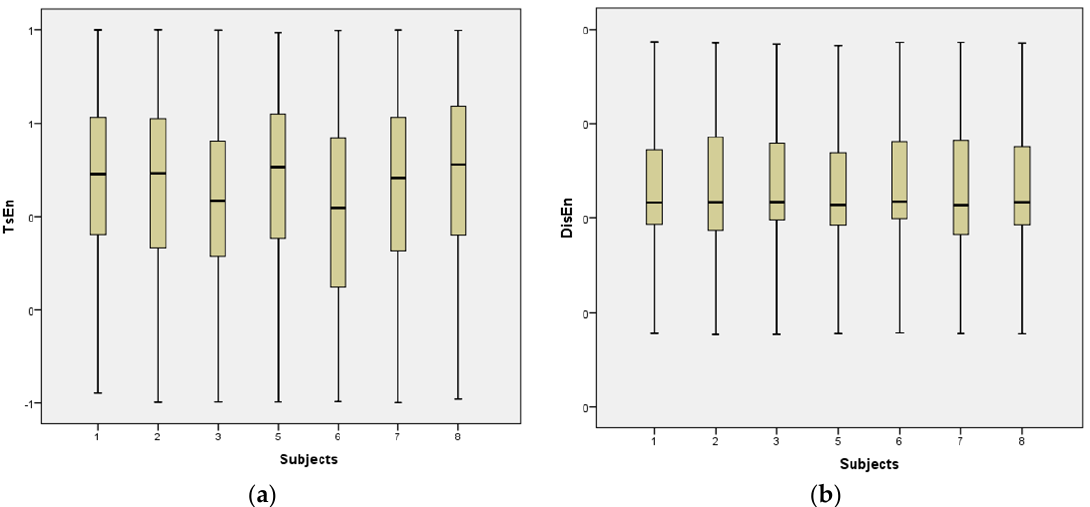
Figure 7. ( a ) The TsEn distribution of features and ( b ) the DispEn distribution of features for each of the eight people who took part in the EEG MI-based BCI dataset.